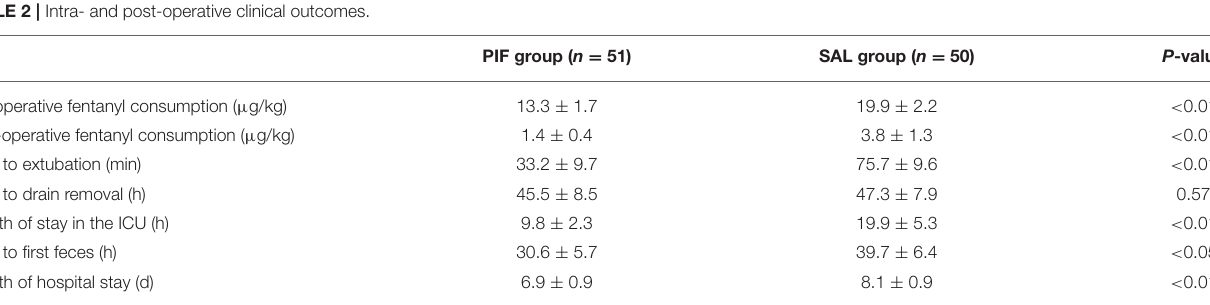
TABLE 2 | Intra- and post-operative clinical